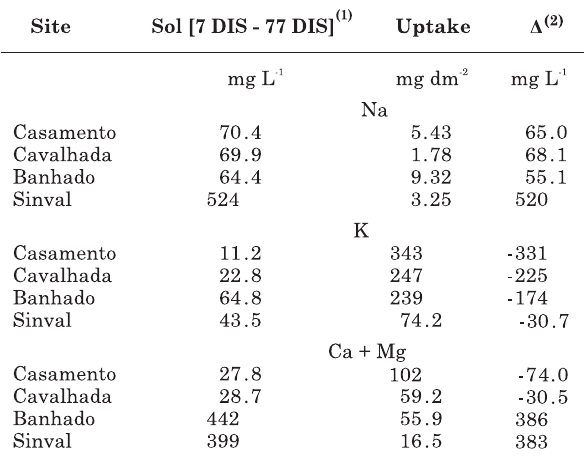
Table 4. Ion concentration in the soil solution, cation uptake at full flowering and difference between ion concentration in the soil solution and ion uptake by irrigated rice, grown on soils with different salinity